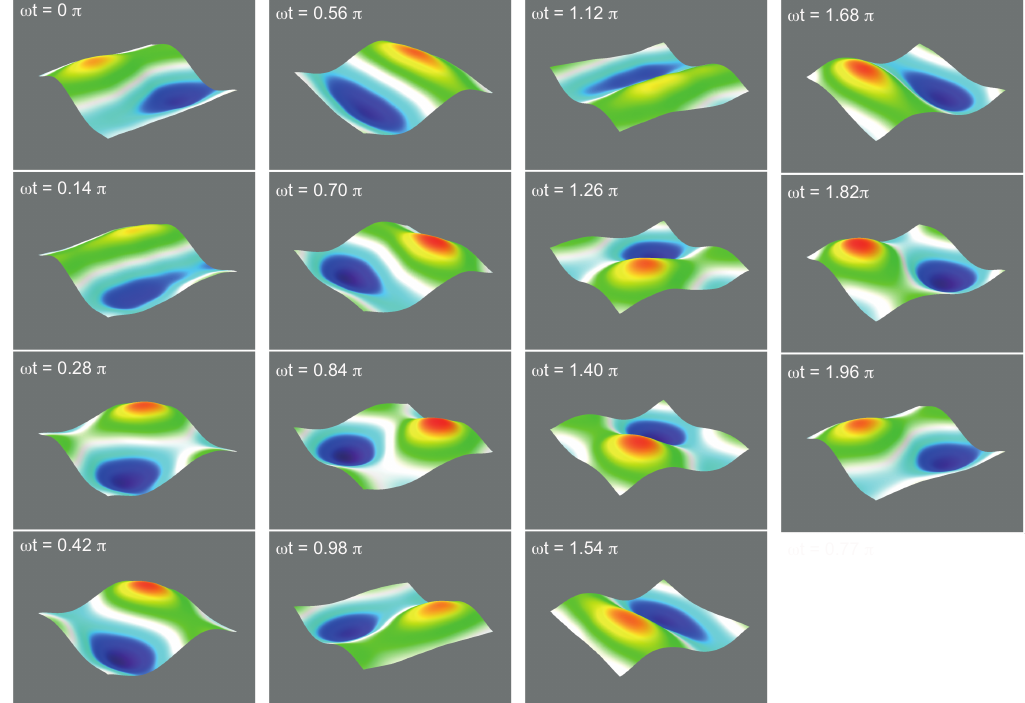
Figure 2. Experimentally measured temporal evolution of the wave field for two orthogonal standing surface waves, phase-shifted by φ = π /2 within a λ × λ box. Experimental parameters: 300 mm cavity, f = 2 π / ω = 3.9 Hz, λ = 104 mm, H = 2.5 mm, video acquisition rate is 55